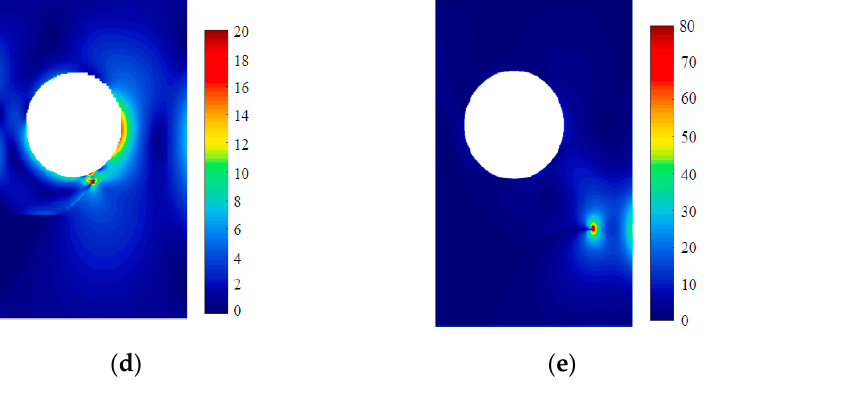
Figure 13. Von Mises stress distribution, ( a ) h = 15, ( b ) h = 10, ( c ) h = 5, ( d ) h = 15 [41] , ( e ) h = 10 [41] , and ( f ) h = 5 [41] .